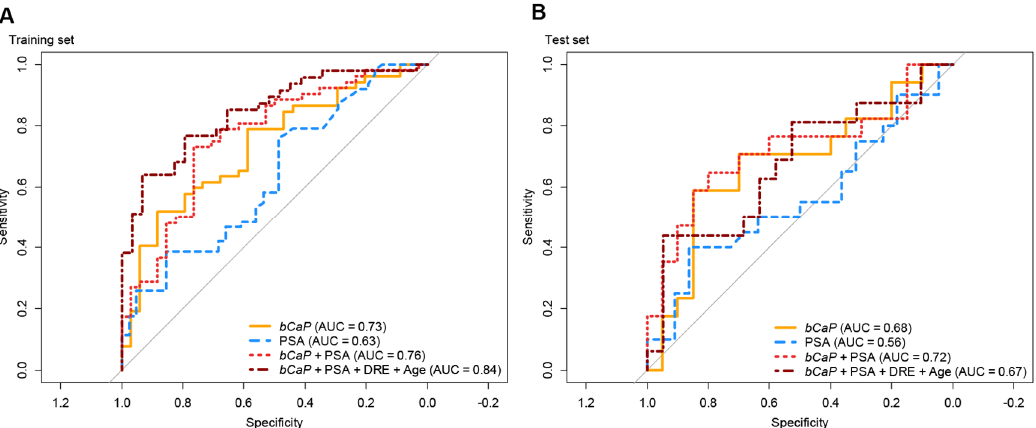
Figure 2. Receiver operating characteristic (ROC) curve analysis in training ( A ) and test ( B ) sets for predicting malignant outcome of TRUSbx. Orange: pCaP ; blue: PSA; red: logistic regression model of bCaP + PSA; dark red: logistic regression model of bCaP + PSA + DRE + Age; PSA: prostate specific antigen; DRE: digital rectal examination.